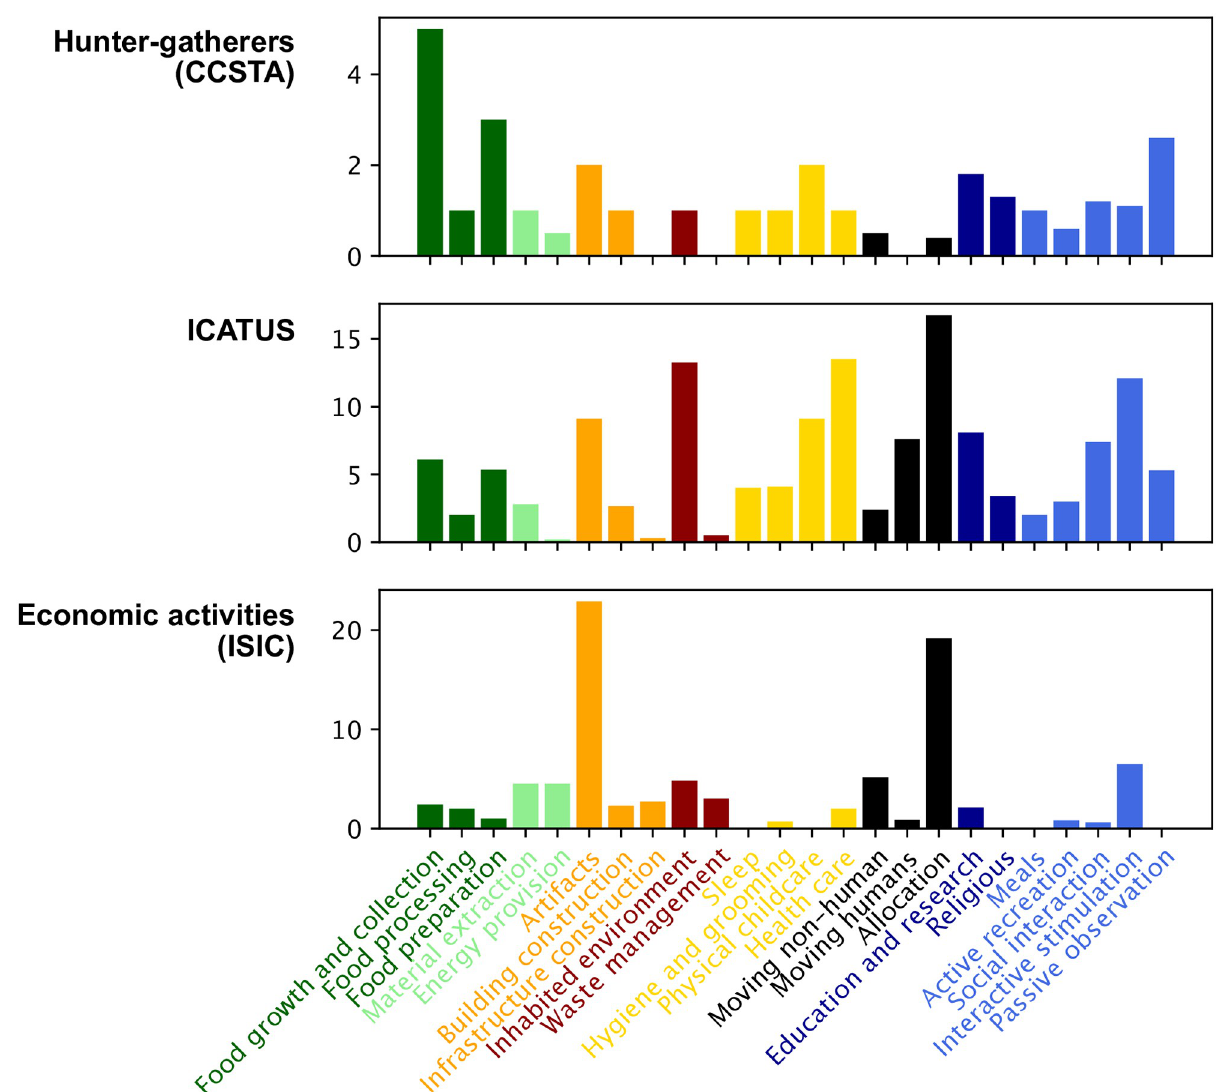
Fig 3. Sum of time fractions by category. Each bar shows the sum of all time fractions associated with each category, for each of the three illustrative lexicons. The sum reflects how frequently activities were associated with each MOOGAL